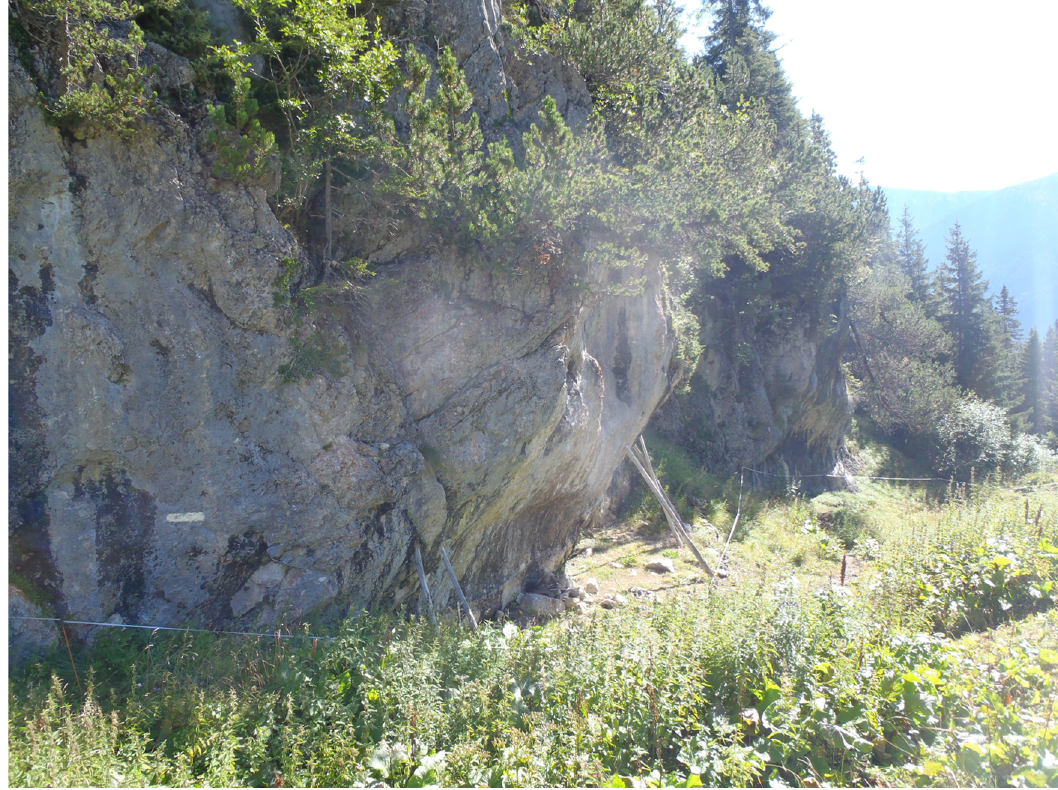
Figure 6: Rock shelter Schneiderküren , seen from the north -